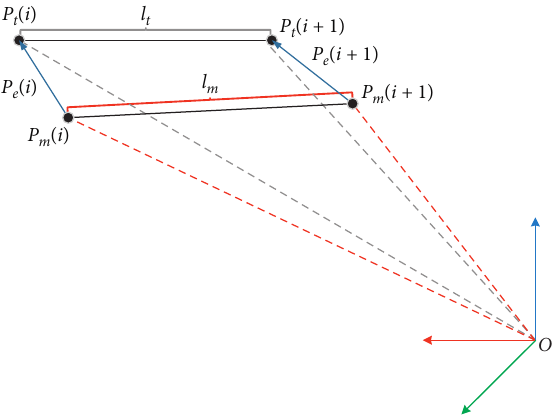
Figure 2: The definition of distance